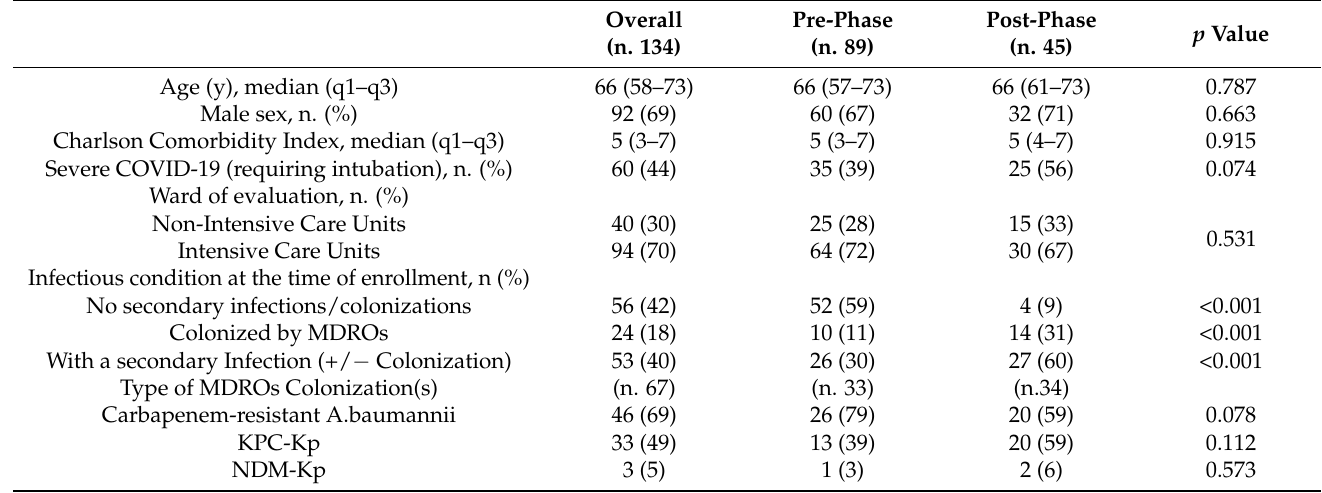
Table 1. General characteristics of the study